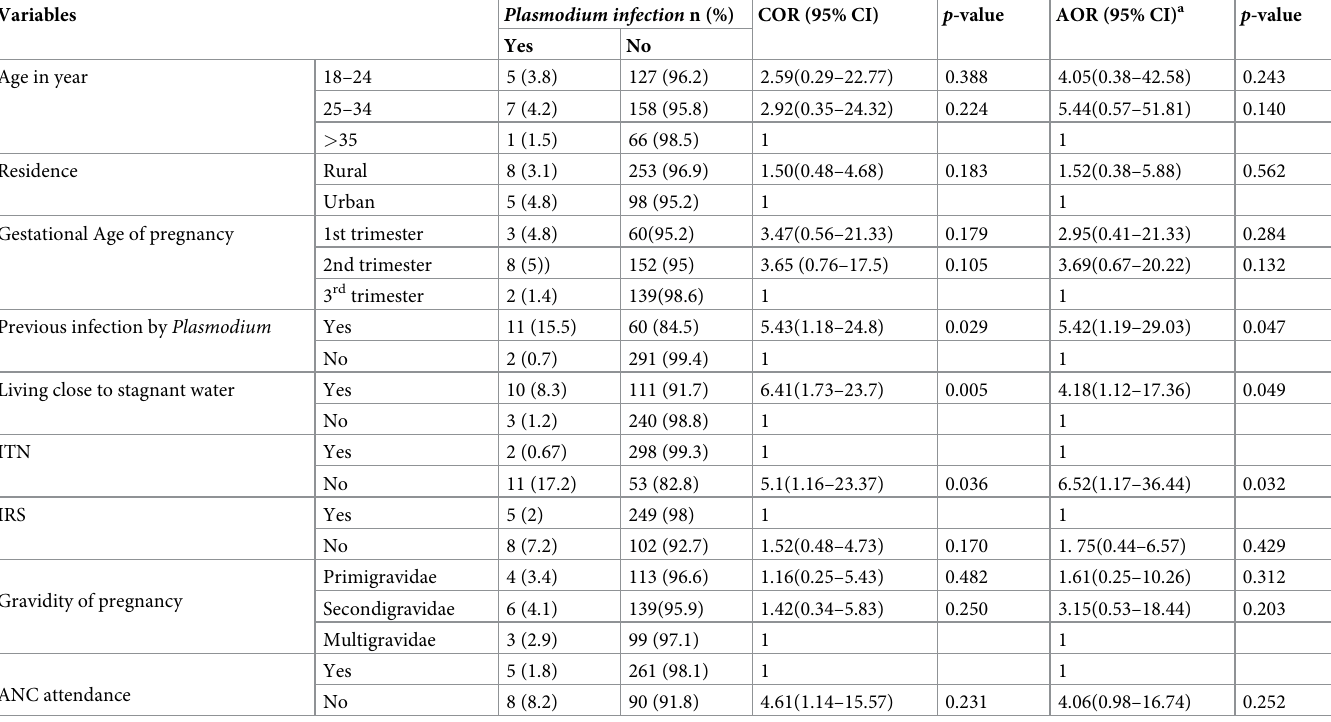
Table 2. Predictors of asymptomatic Plasmodium infection among pregnant women in Merti district, March-September 2018 (N = 364).